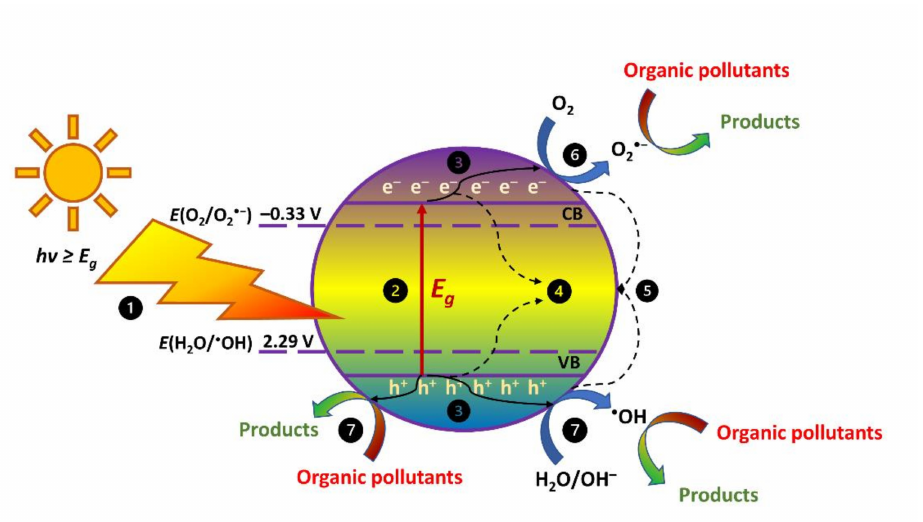
Figure 5. Photocatalytic process over TiO 2 : ( 1 ) Photon absorption; ( 2 ) Generation and separation of electron-hole pairs (e - and h + ); ( 3 ) Transport of electrons and holes in the bulk to the photocatalyst surface; ( 4 ) Recombination of electrons and holes in the bulk; ( 5 ) Surface recombination of electrons and holes; ( 6 ) Reduction reaction on TiO 2 surface; ( 7 ) Oxidation reactions on TiO 2